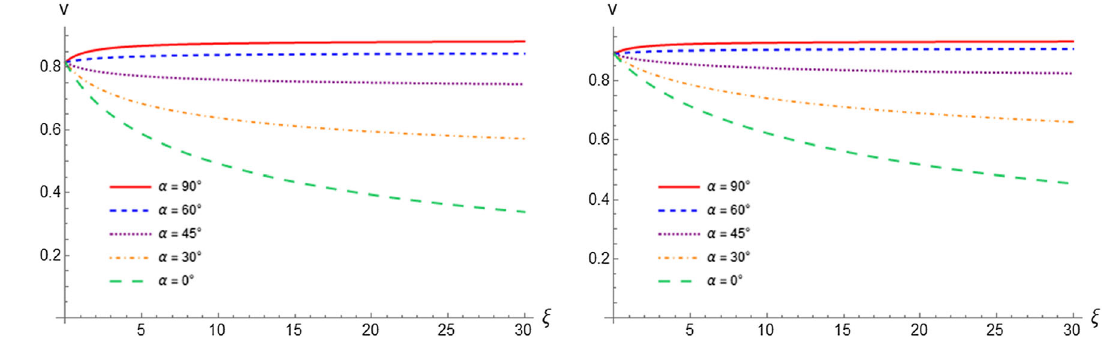
Fig. 5 Plots of the absolute value of upstream velocity | v (ξ | α) | as a function of the anisotropy parameter ξ for α = π/ 2 (solid), α = 2 π/ 3 (dashed), α = π/ 4 (dotted), α = π/ 6 (dash-dotted) and α = 0 (long dash) for σ = 5 (left) and σ = 10 (right)